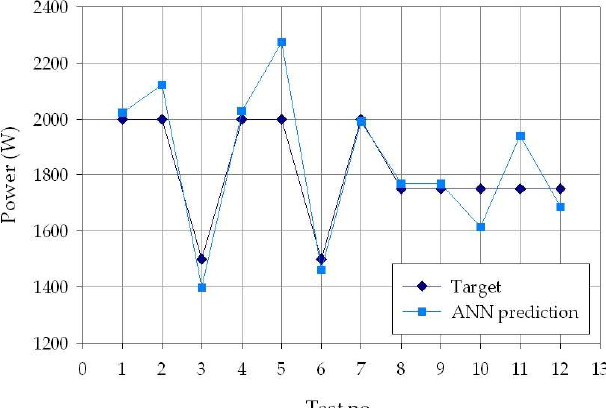
Figure 6. Experimental (blue diamond marks) and ANN-estimated (light blue square marks) laser power values, p , for each of the p = 30 experimental conditions.